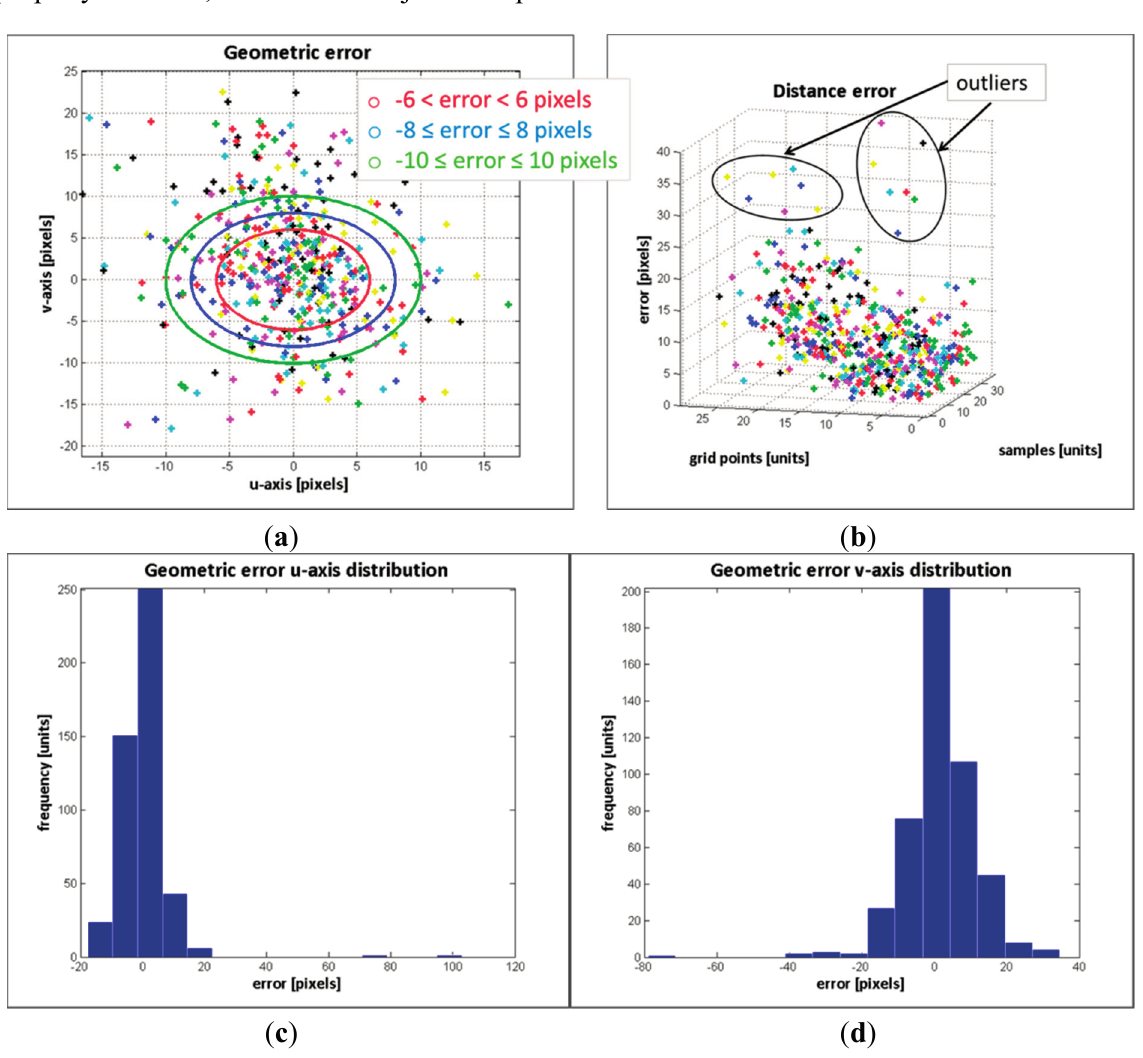
Figure 16. Error evaluation of the experimental tests corresponding to group #2. ( a ) geometric error; ( b ) distance error; ( c ) error distribution in u -axis; ( d ) error distribution in v